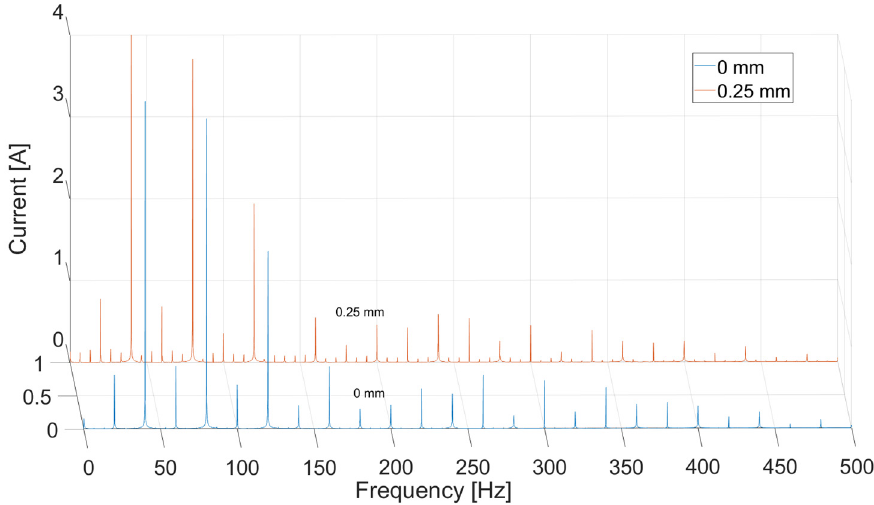
Figure 15. Phase current in frequency domain of sinusoidal source with 2 additional harmonics.